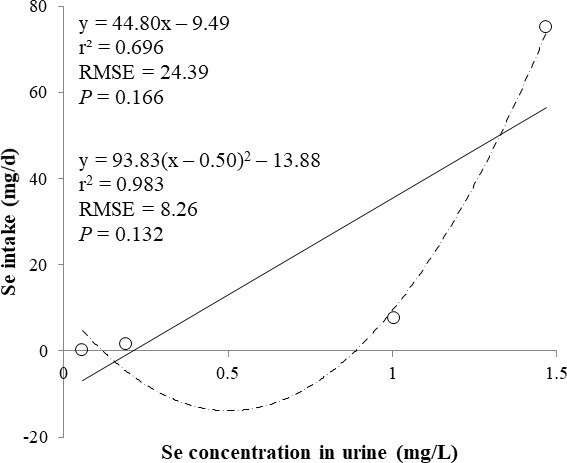
Linear and quadratic regression equations for estimating daily selenium (Se) intake (mg/d) based on the Se concentration in urine (mg/L).Each data point represents least squares mean of four observations. r2, coefficient of determination; RMSE, root mean square of error.